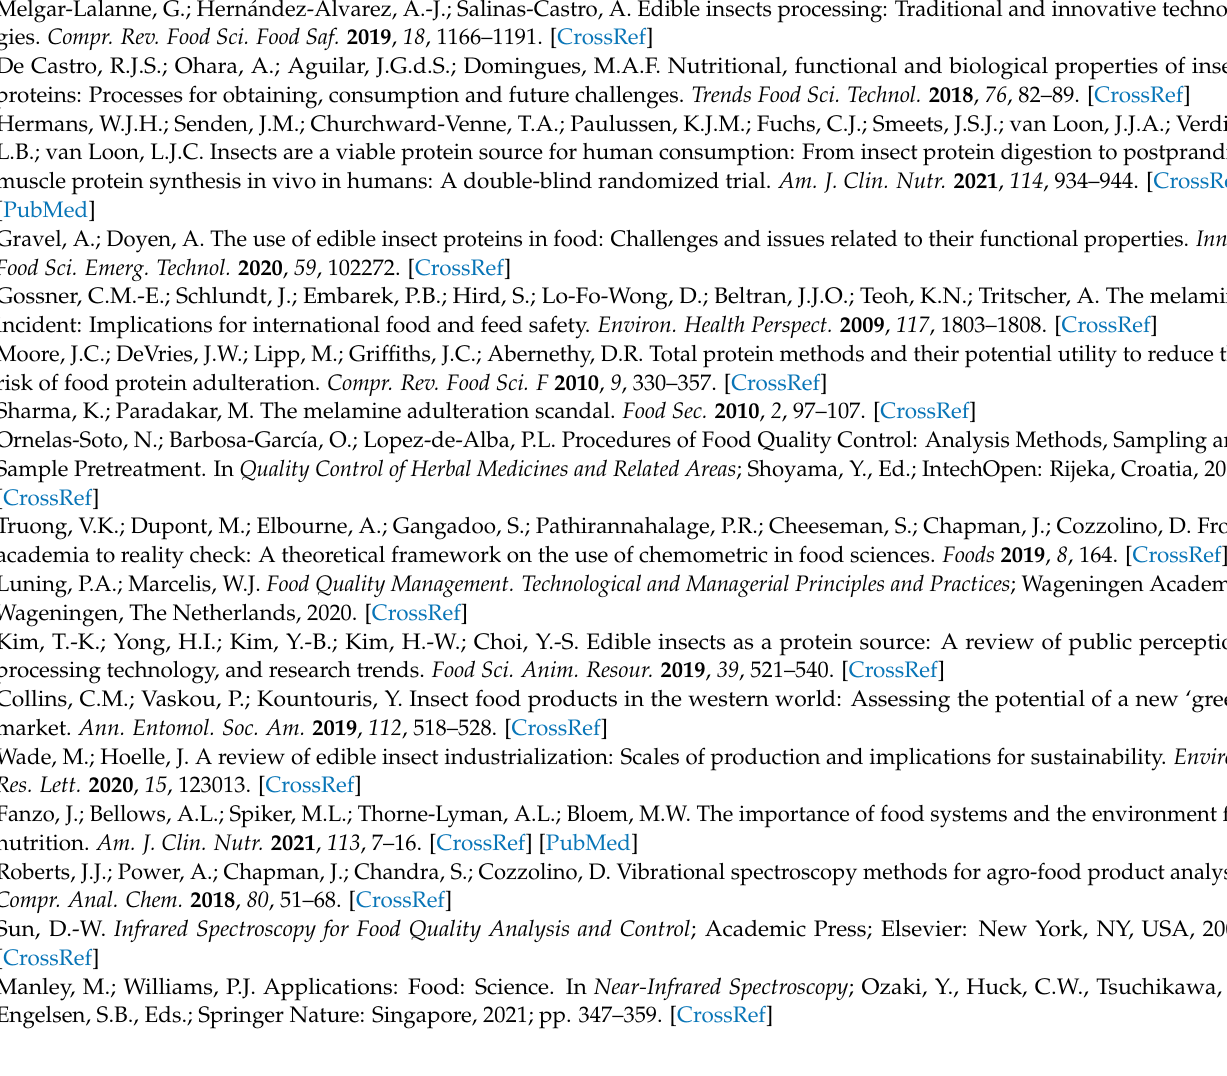
Supplementary Materials: The following are available online, Figure S1: (Left) PCA score plot for PC1 vs. PC2 and (Right) the explained variance for the spectral set of milled bars (spectrometer: Büchi NIRFlex N-500). Figure S2: exemplary spectra (prior any pretreatments) of intact and milled bars as well as isolated chocolate coating (spectrometer: Büchi NIRFlex N-500). Figure S3: the exemplary spectra of an intact bar and chocolate coating after baseline offset correction (spectrometer: Büchi NIRFlex